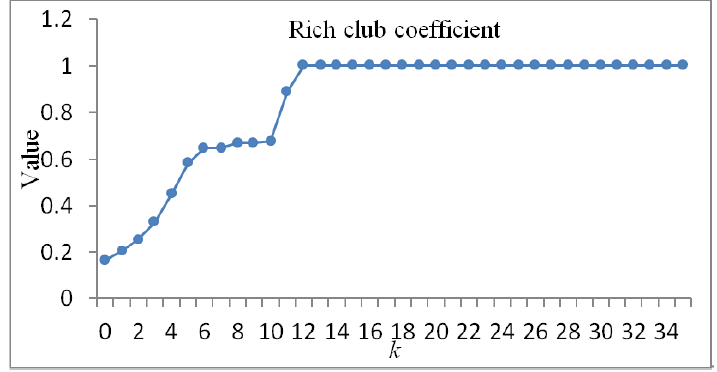
Figure 4. Rich-club coefficient.